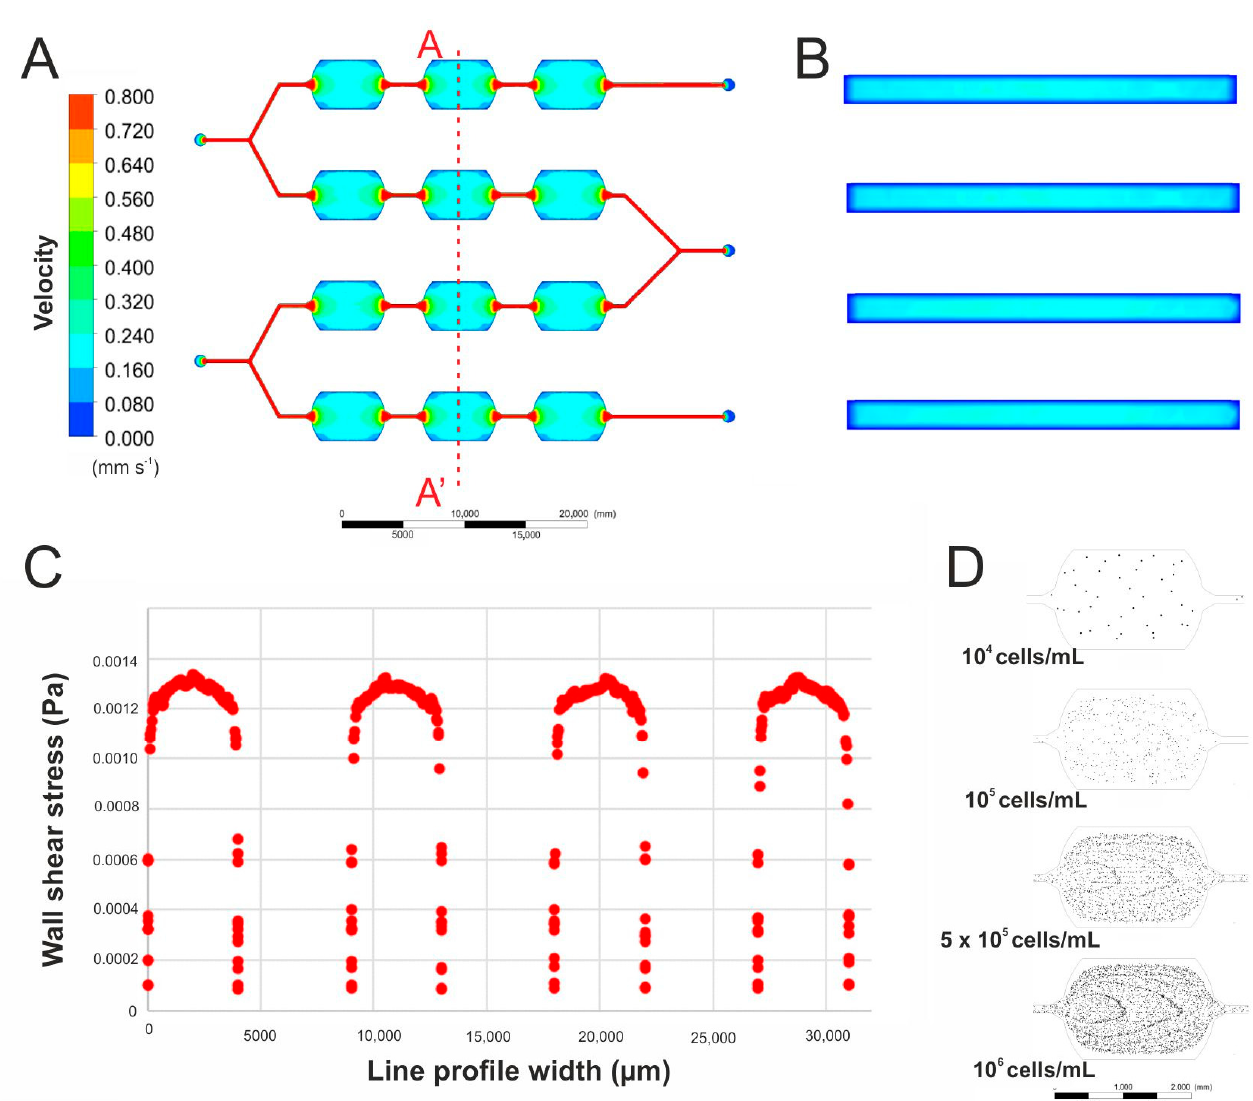
Figure 3. ( A ) A simulation of the culture medium flow in the designed microfluidic system. ( B ) A simulation of the culture medium flow in the culture microchambers (cross-section view). ( C ) Wall shear stress simulation in four culture microchambers. ( D ) Simulations of cell distribution after introducing a suspension of cells of different densities into the microsystem.